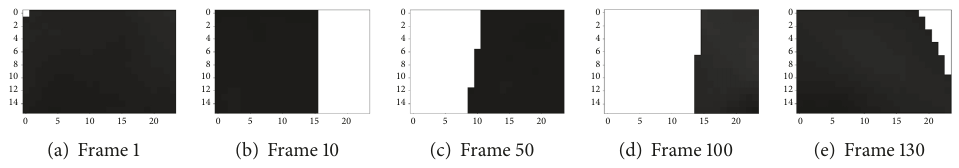
Figure 3: Image Samples from the Middle Vision Sensor.